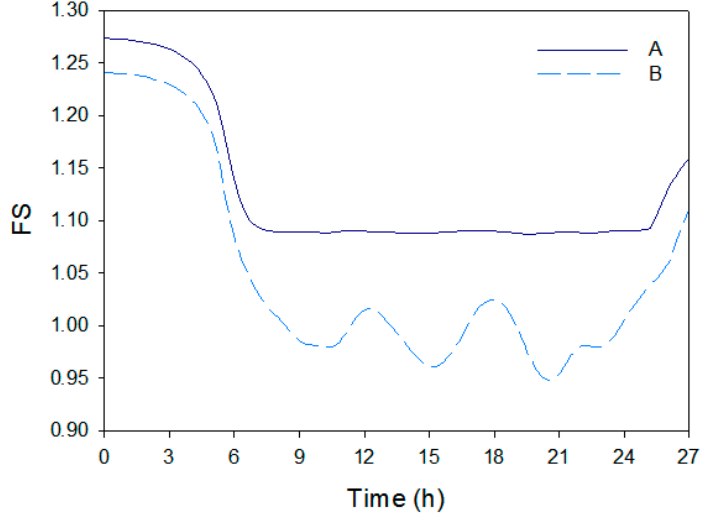
Figure 10. Simulated results of FS at Locations A and B during Typhoon Meigi (1 m below ground).